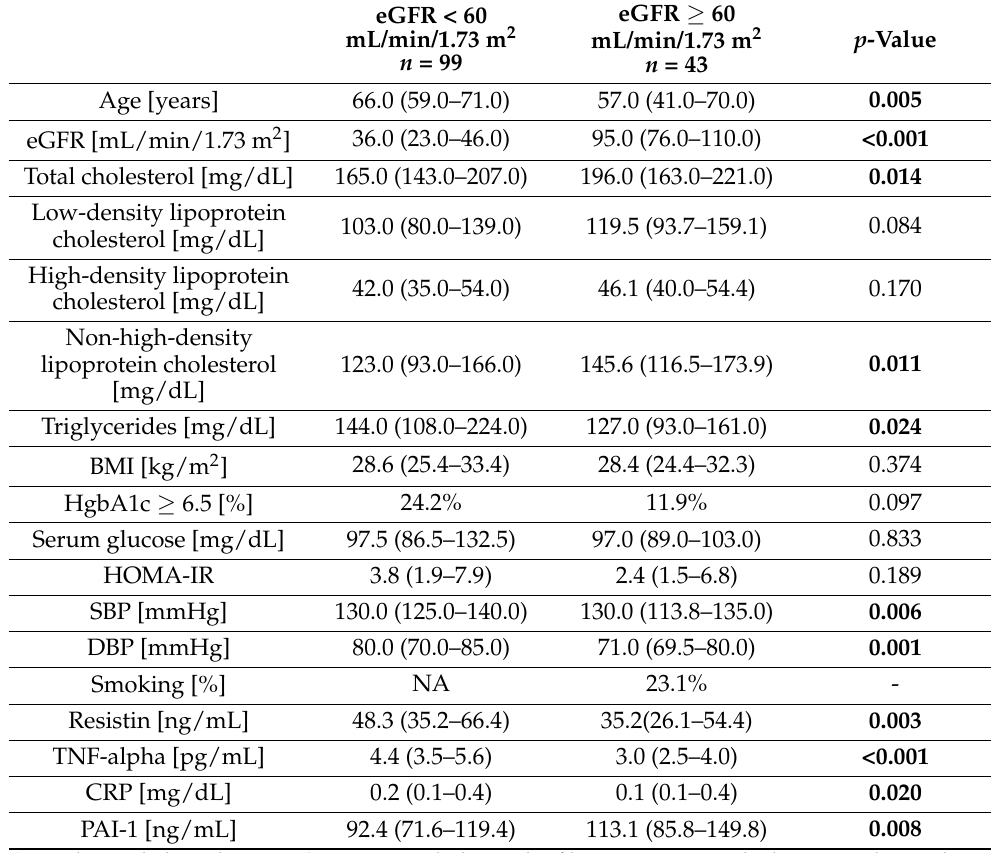
Table 1. Clinical data of the studied